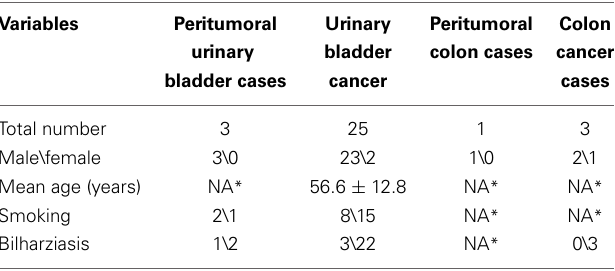
Table 1 | The clinical characteristics of patients in the